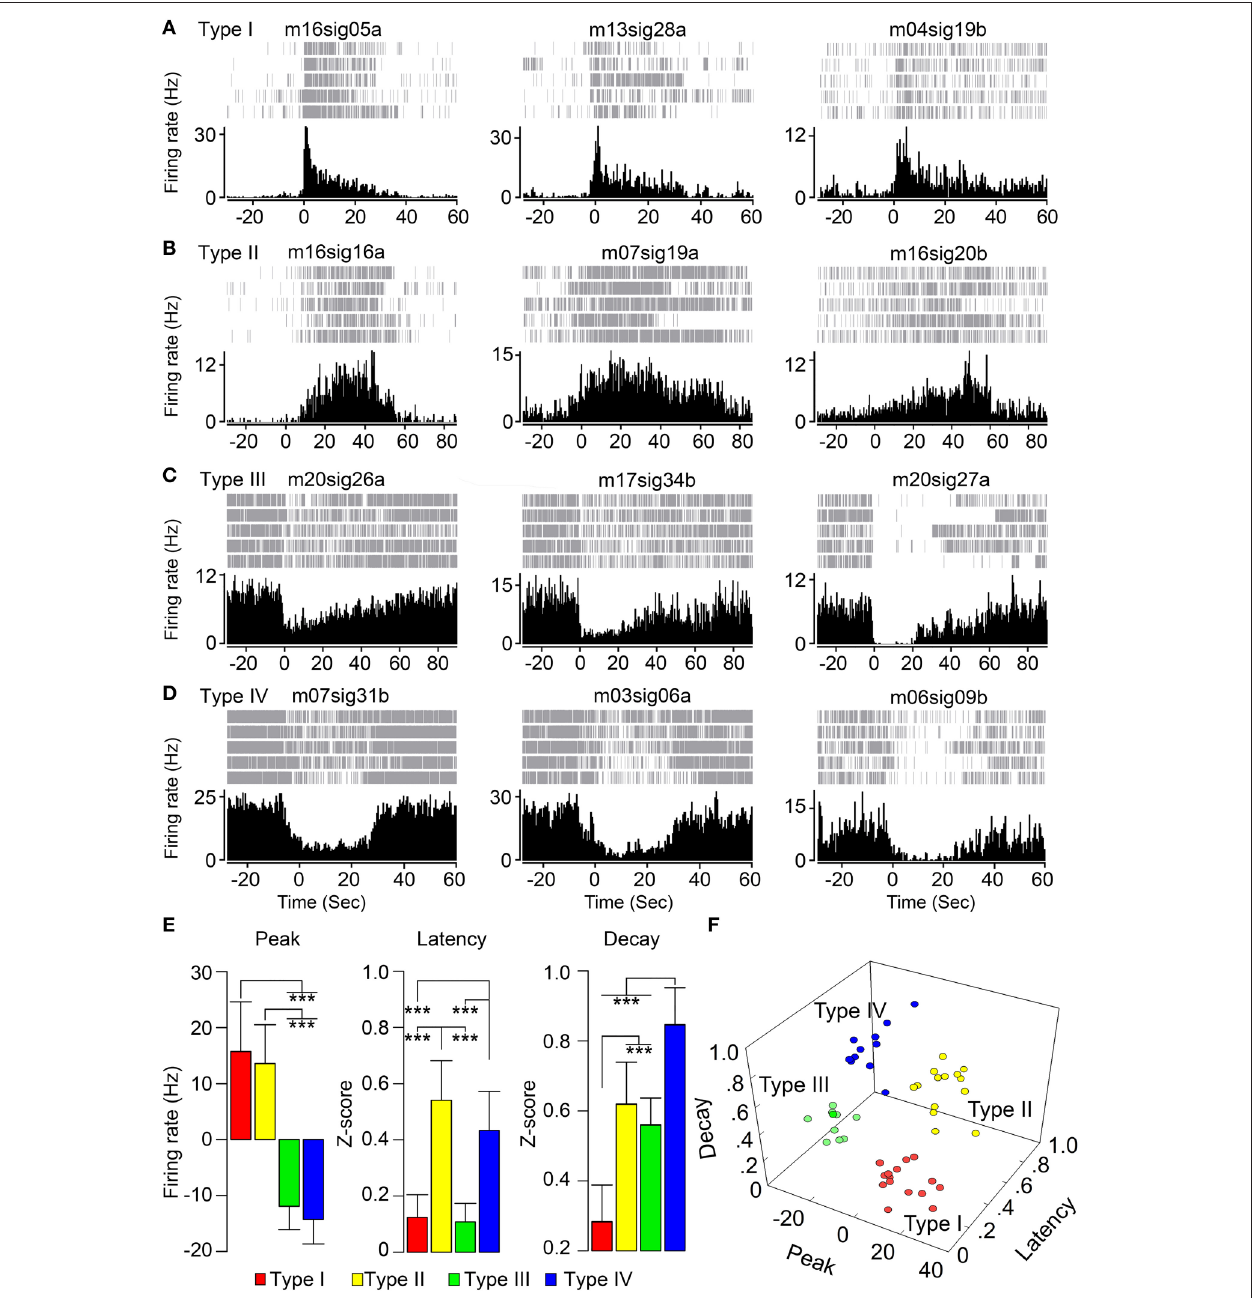
FIGURE 1 | Distinct feeding related firing patterns of hypothalamic neurons. (A) Type I of FRNs with the sharp increase of firing rate at beginning of food intake. (B) Type II of FRNs with an increase of firing rate. (C) Type III of FRNs with the sharp decrease of firing rate. (D) Type IV of FRNs with sustain decrease of firing rate during feeding. (E) Feeding related firing patterns of FRNs were compared by three parameters of their perievent time histogram: peak response, peak latency and peak decay ( *** p < 0.001, multiple t -test with Bonferroni correction). (F) Four types of FRNs were separated in 3D scatters graph.